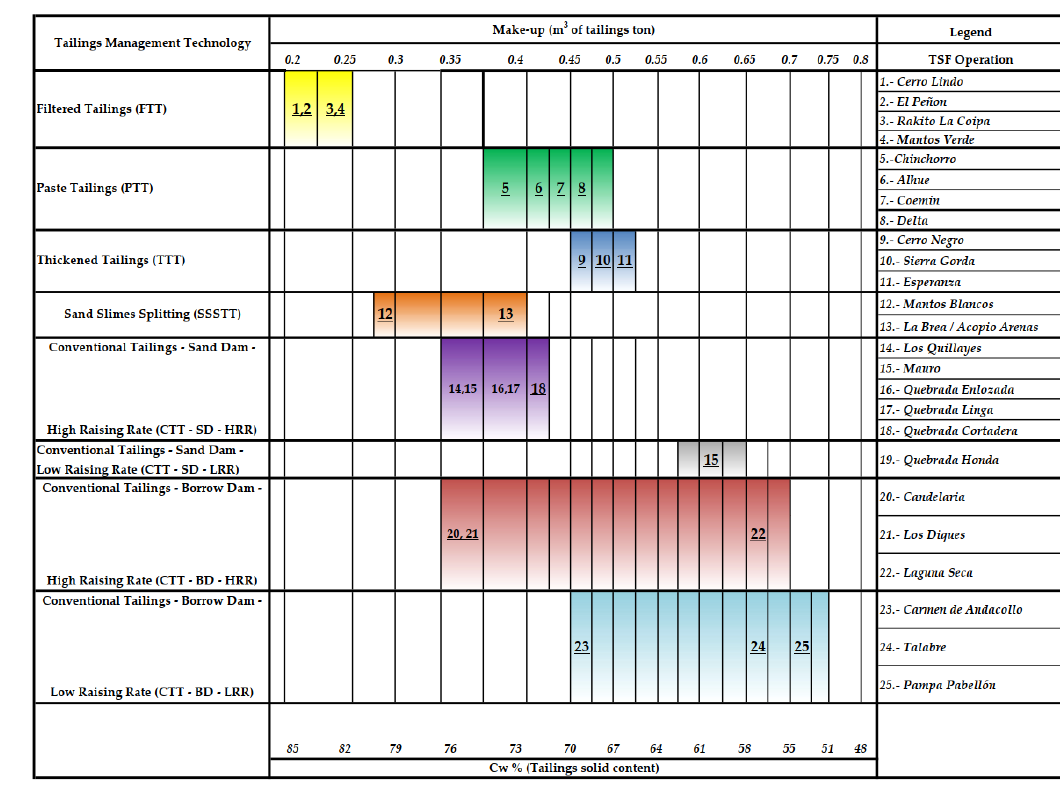
Figure 12. Make ‐ up tailings management technologies comparison of performance. Figure 12. Make-up tailings management technologies comparison of performance. Table 2. Water Recovery Comparison between Tailings Management